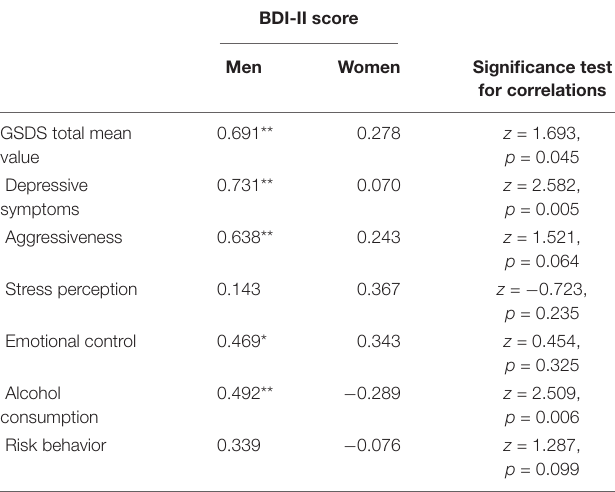
TABLE 3 | Pearson correlations between the Beck Depression Inventory Revision (BDI-II) and Gender-Sensitive Depression Screening (GSDS) total score and subscales in an age- and BDI-II score-matched sample of male ( n = 21) and female ( n = 21) forensic psychiatric inpatients.